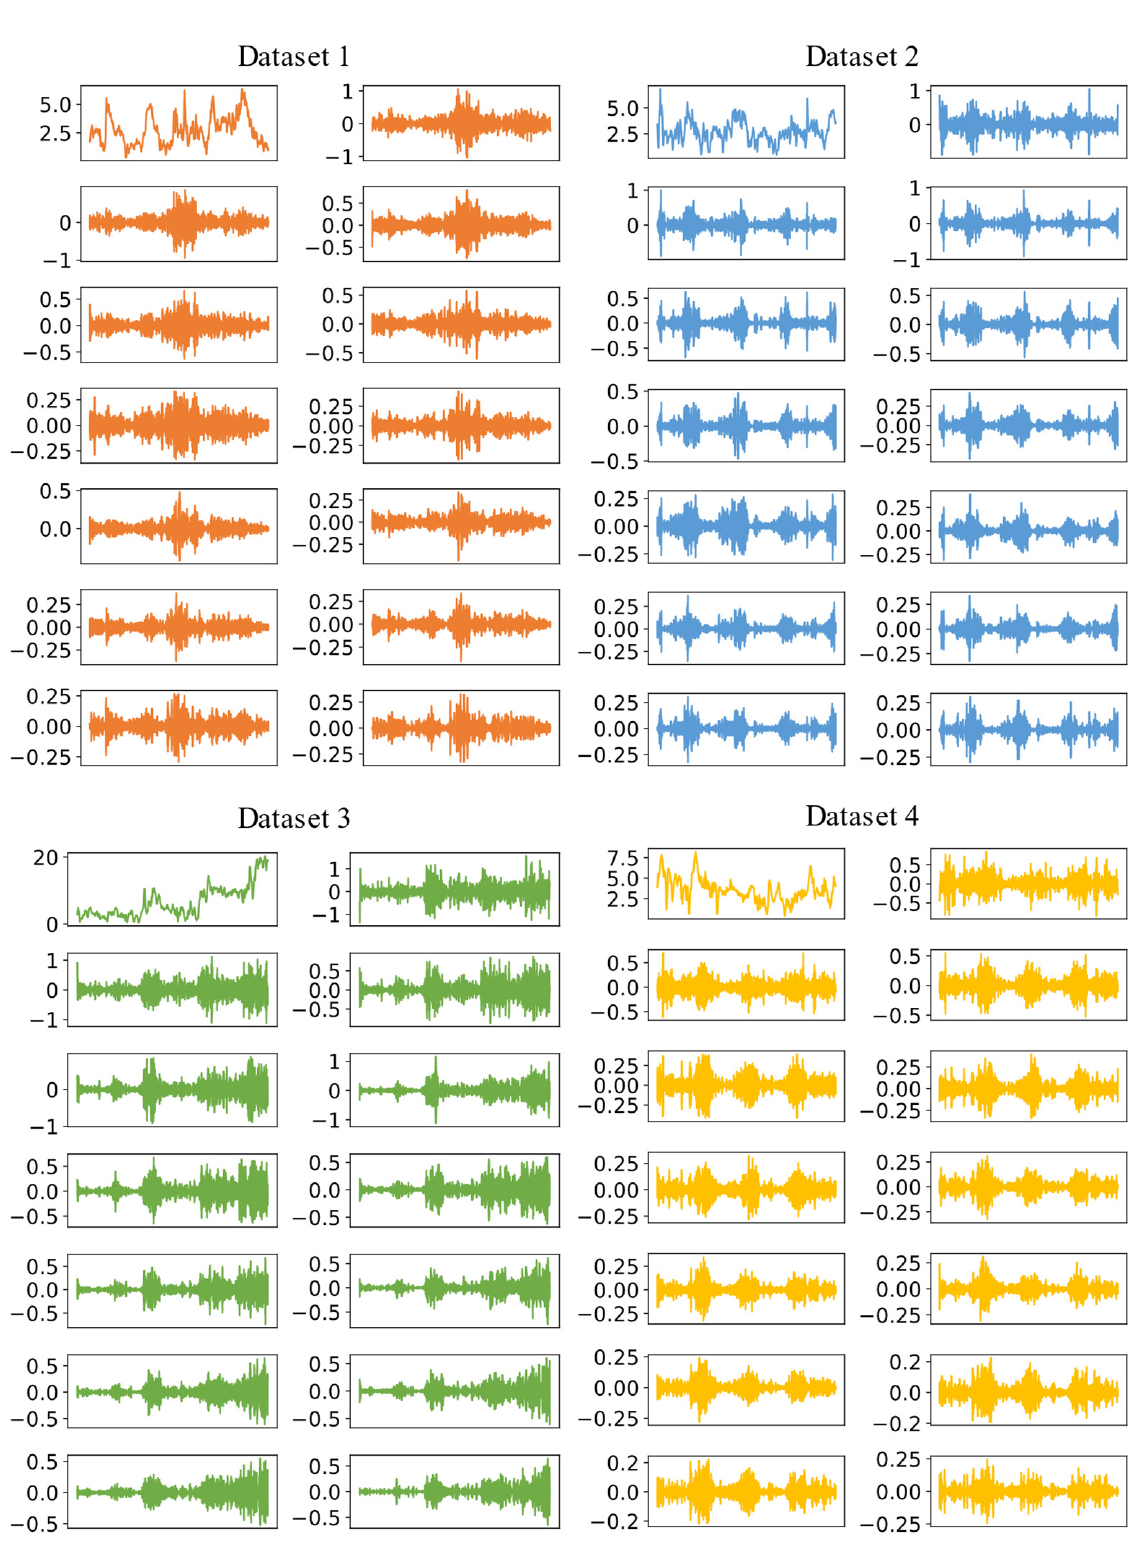
Figure 4. Time series decomposition of wind speed data using SSA.